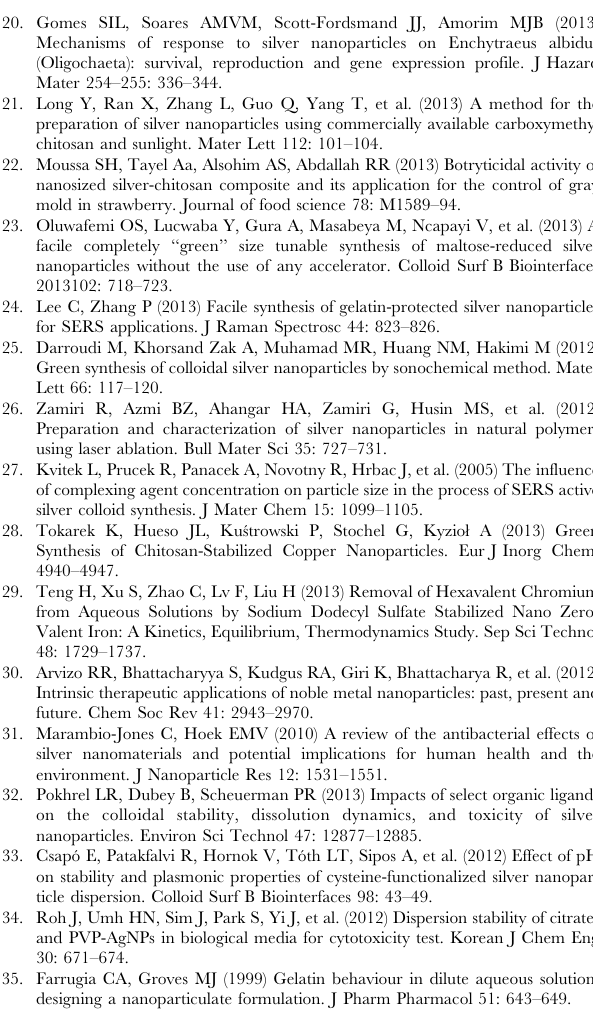
Figure S3 TEM images and corresponding particle size distribution histograms of AgNPs reduced by sodium borohydride